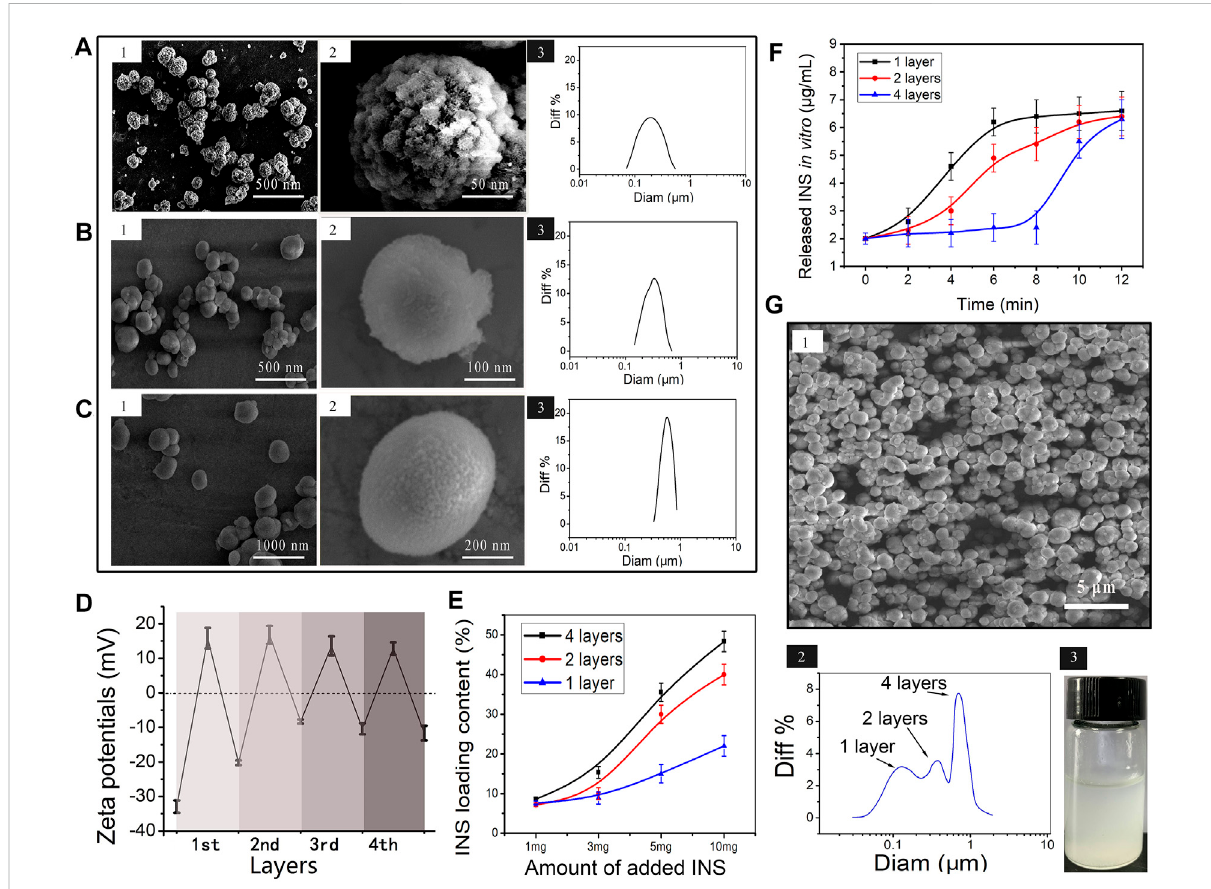
FIGURE 2 Characterization of the mmLbL-INS microcapsules. (A – C) SEM images and DLS results of LbL-INS microcapsules with (A) one layer, (B) two layers, and (C) four layers. (1) SEM images, (2) high-magni fi cation SEM image, (3) dynamiclight scattering (DLS) results. (D) Zeta potentials of multiple LbL-INS microcapsules with different layers. (E) Relationship between the initial INS concentration and INS loading content in the LbL-INS microcapsules. (F) INS release behavior of multiple LbL-INS microcapsules in pH 6.5 solution. (G) SEM images, DLS results, and the image of mmLbL-INS